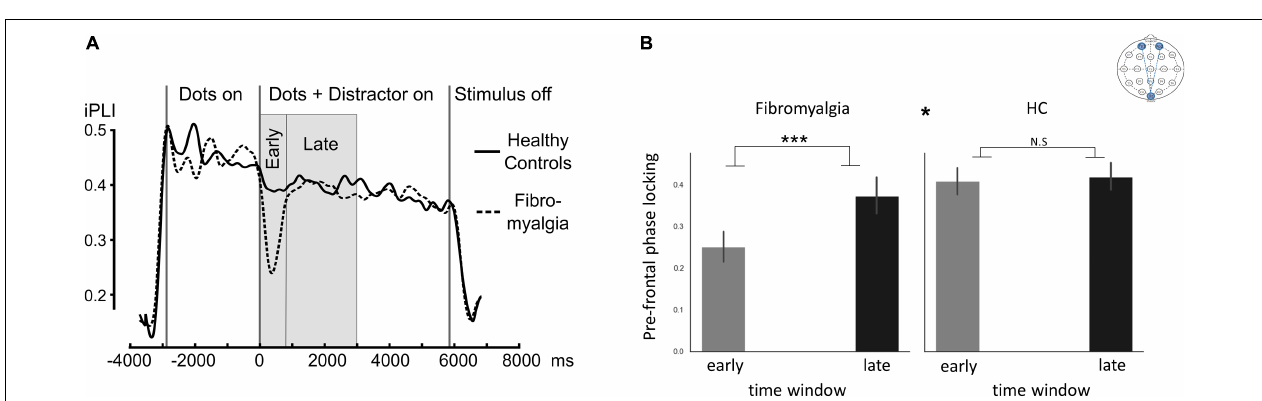
FIGURE 2 | ssVEP amplitudes. (A) Mean group results of a time sequence of a single trial in the ssVEP task. Each trial started with a 1-second presentation of a scrambled picture, followed by the appearance of flickering dots (at a rate of 7.5 Hz) for 2.9 s. Consequently, a negative or neutral picture appeared for 5.8 s behind the dots. (B) Bar graphs illustrate the mean of ssVEP amplitude change relative to baseline in the early and late time windows, indicating different patterns of response, specifically a triple interaction of group*time-window*distractor-type driven by a large difference between distractor types at the early time window in the healthy control group (HC panel, left-hand set of bars), but not in the FMS group (Fibromyalgia panel, left-hand set of bars) and stronger response to negative compare the neutral stimulus in the FMS (Fibromyalgia panel, right-hand set of bars) but not in the HC group (HC panel, right-hand set of bars) in the late time window. Error bars represent SEM. The * at the middle top part of panel (B) is indicating the significant triple interaction group*time-window*distractor-type. Significant post hoc t -tests for the differences between distractor types, within each time window within each group are also indicated. * p < 0.05 ∗∗ p < 0.005. Post hoc Scheffé correction. This analysis is based on data from 58 participants (39 FMS and 19HC).